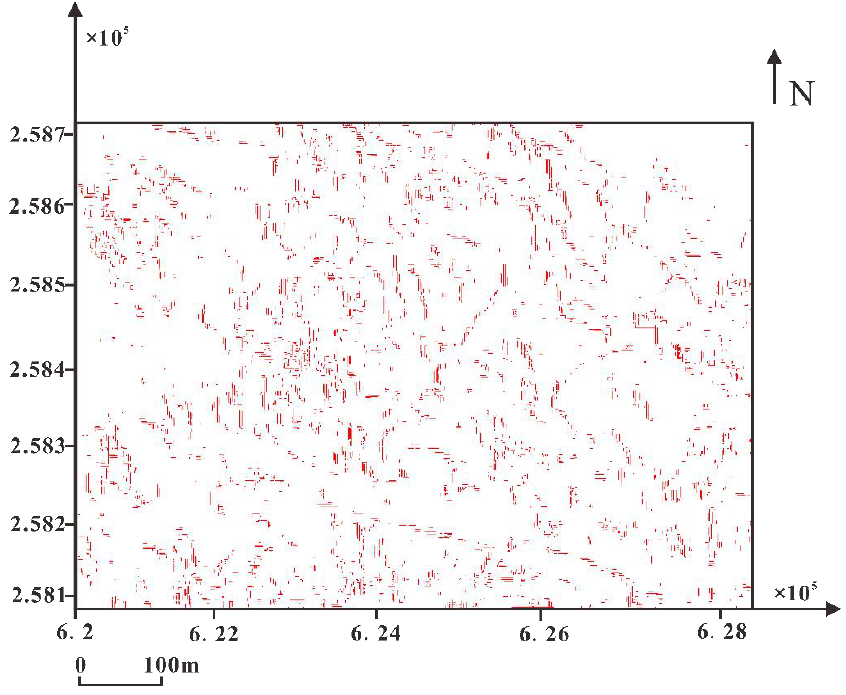
Figure 10. Lineament extraction results (improved line segment tracking method).